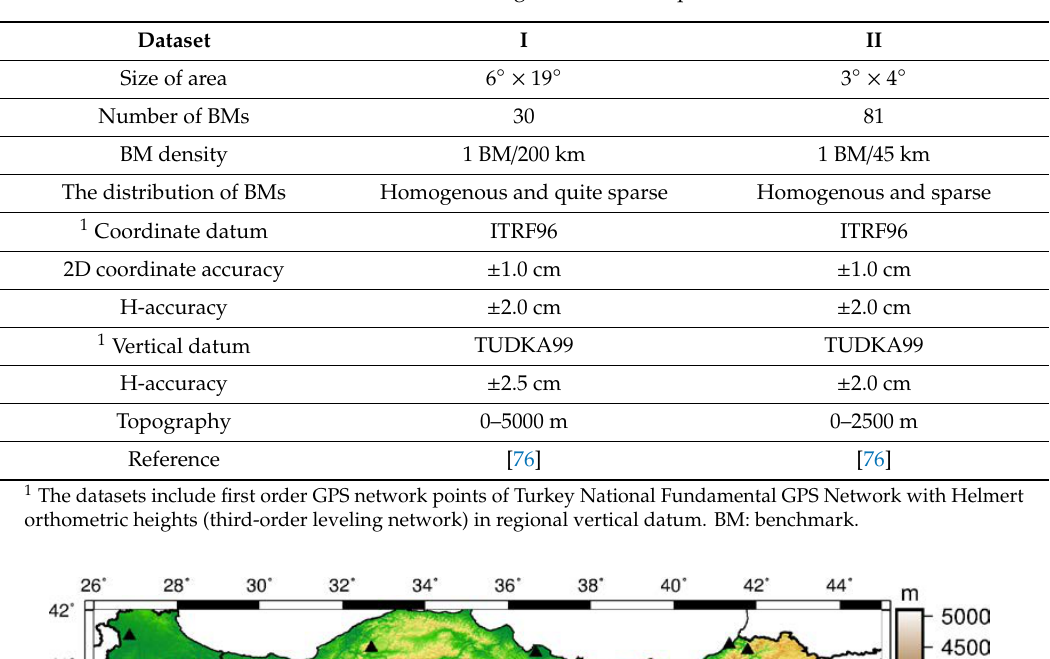
Table 2. GPS / leveling datasets description.